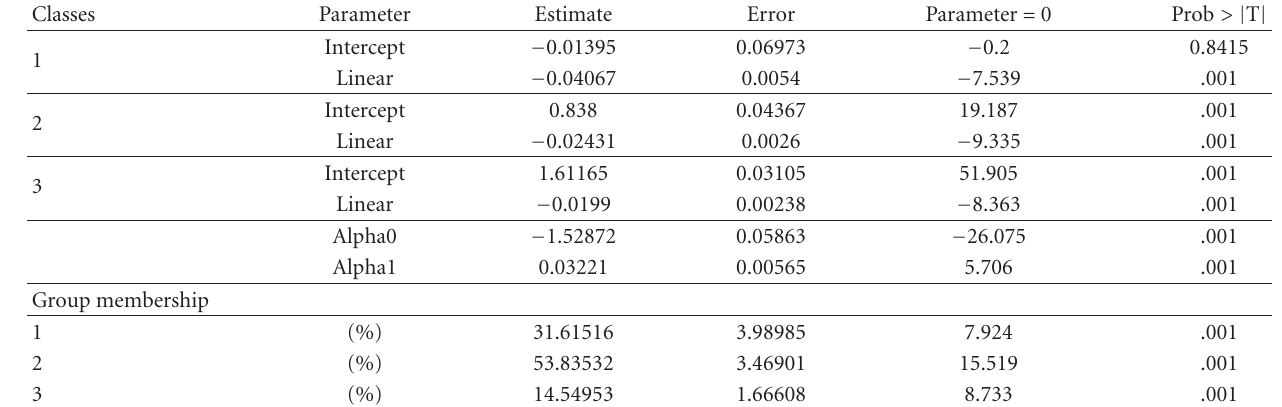
Table 4: Latent class growth analysis results for stressful life events including health items.